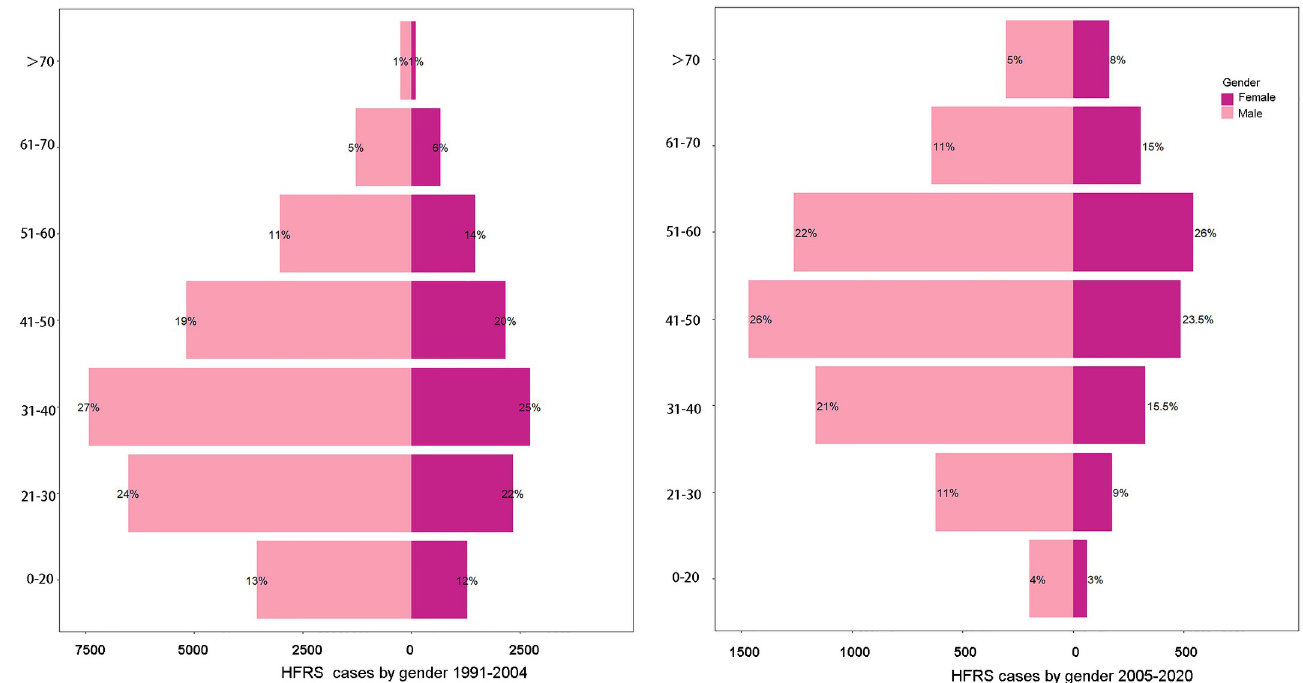
Fig 6. The gender distribution of HFRS cases in Zhejiang Province in different age groups from 2005 to 2020.